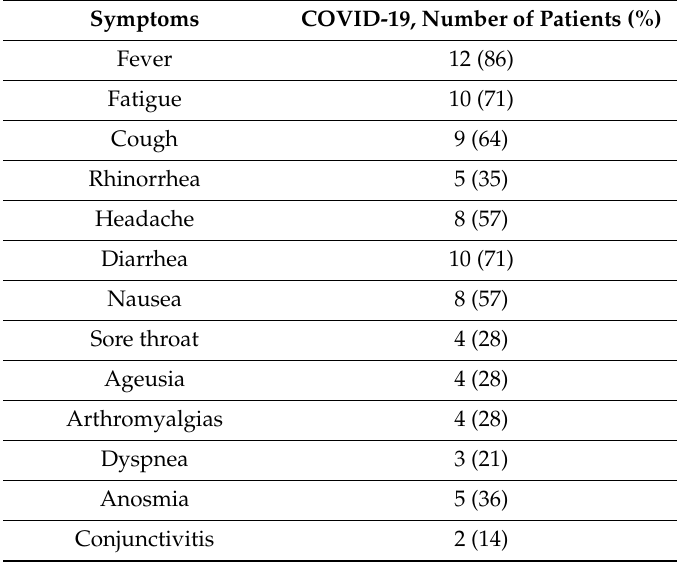
Table 2. Symptom prevalence in the COVID-19 cohort (COVID-19 =